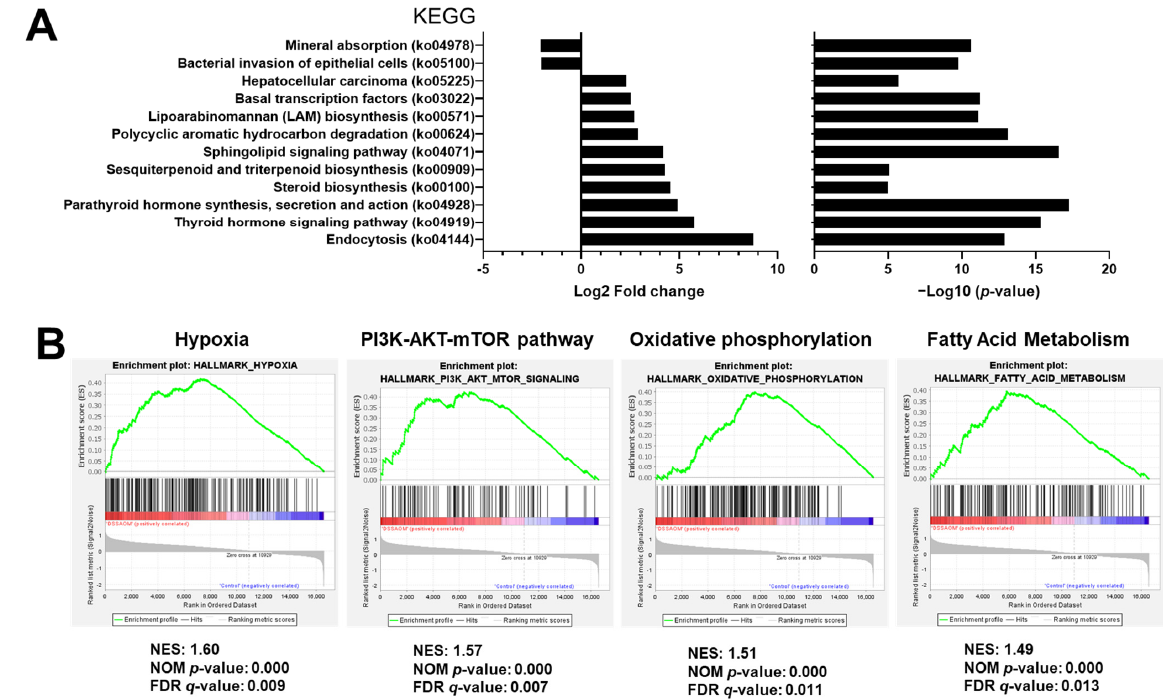
Figure 5. Integrated functional prediction profiling. Piphillin was used to infer and compare functional metabolic pathways from 16S rDNA sequencing abundance data altered in fecal samples from DSS/AOM-treated mice. ( A ) Bar plots showing the fold change (left panel) and the − log10 p value (right panel) of the top 12 KEGG pathways enriched in DSS/AOM-treated mice versus controls (Kyoto Encyclopedia of Genes and Genomes, https://www.kegg.jp, access date: 11 May 2021). ( B ) Gene set enrichment analysis showing key related-signaling pathways altered in the normal mucosal of DSS/AOM-treated and control mice. NES, normalized enrichment score; NOM p value, nominal p value (<0.05 was considered significant); FDR q value: false discovery rate (<0.25 was considered significant), DSS/AOM; dextran sodium sulfate + azoxymethane.